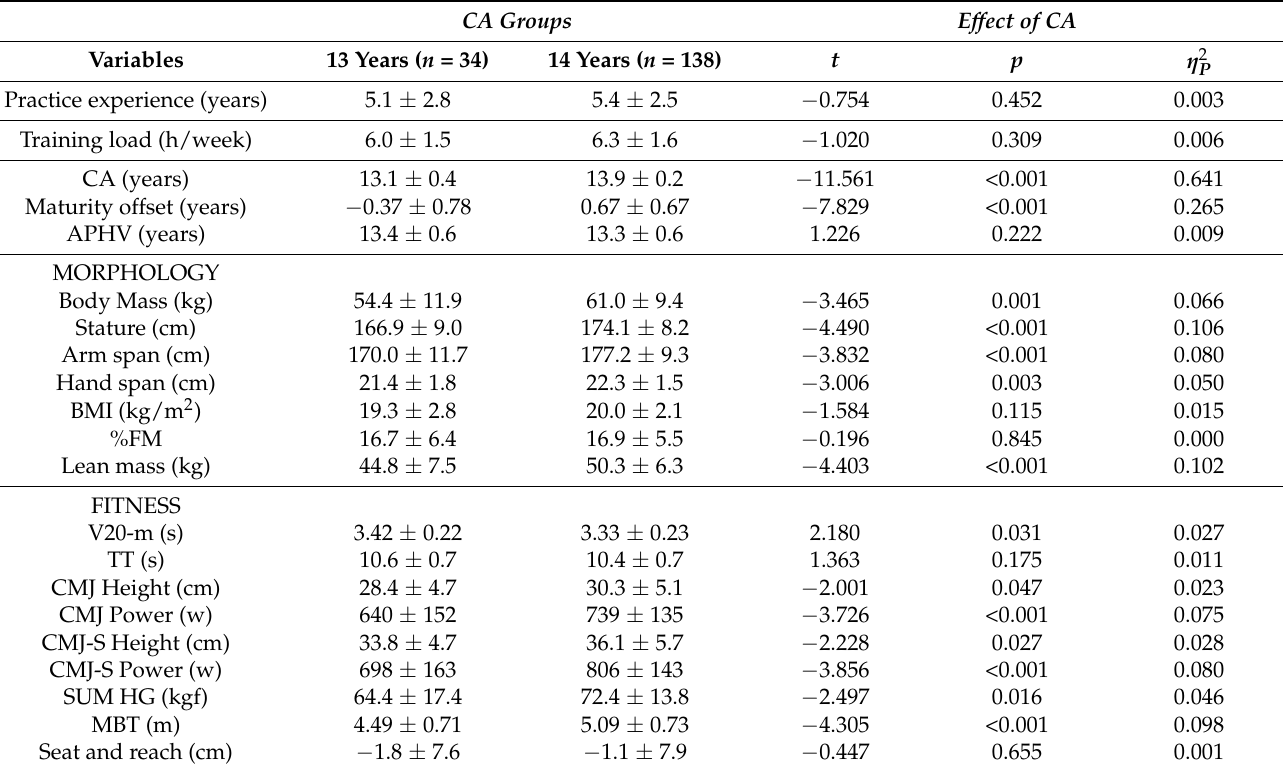
Table 2. Descriptive statistics (mean and standard deviation) and results of independent samples t -tests to evaluate the effect of chronological age groups in U14 years basketball players’